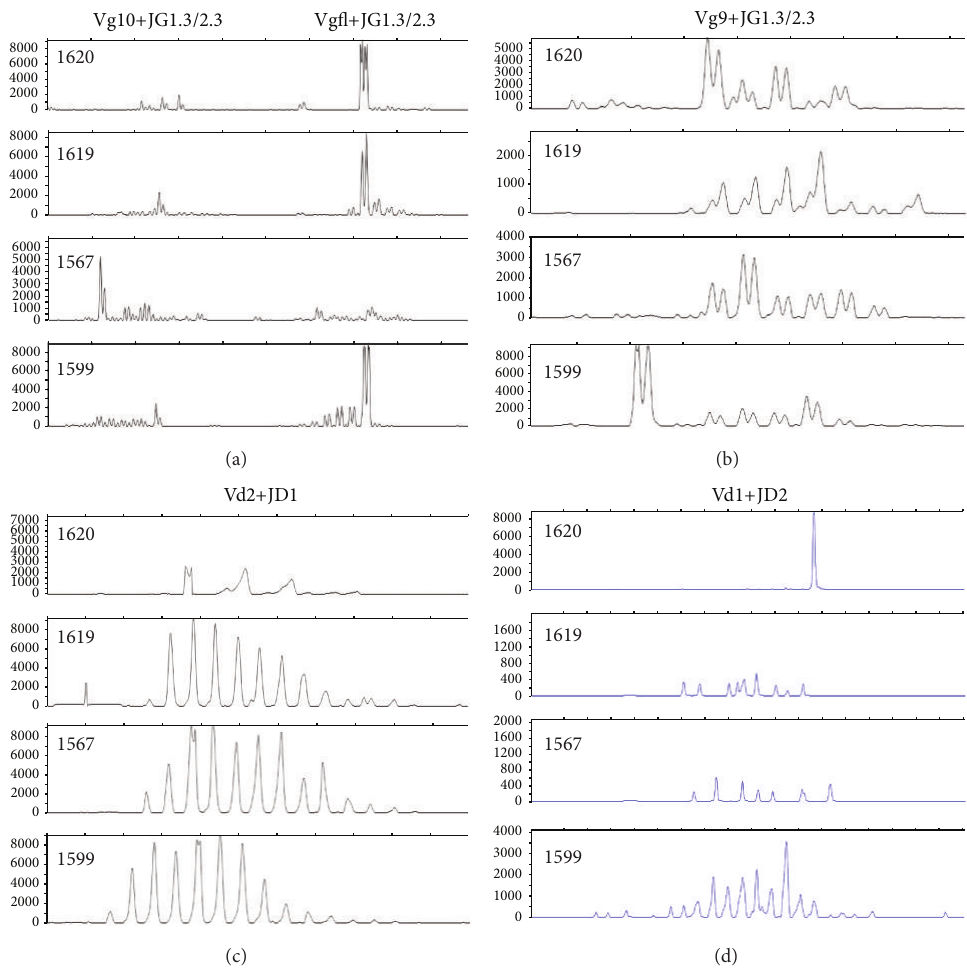
Figure 2: Spectratyping of the 𝛾/𝛿 TCR. Spectratyping was performed on four out of five frozen graft samples (the sample from the fifth patient had too few cells for analysis). Amplification of (a) Vg10 + JG1.3/2.3 and Vgfl(family) + JG1.3/2.3, (b) Vg9 + JG1.3/2.3, (c) Vd2 + JD1, and (d) Vd1 +